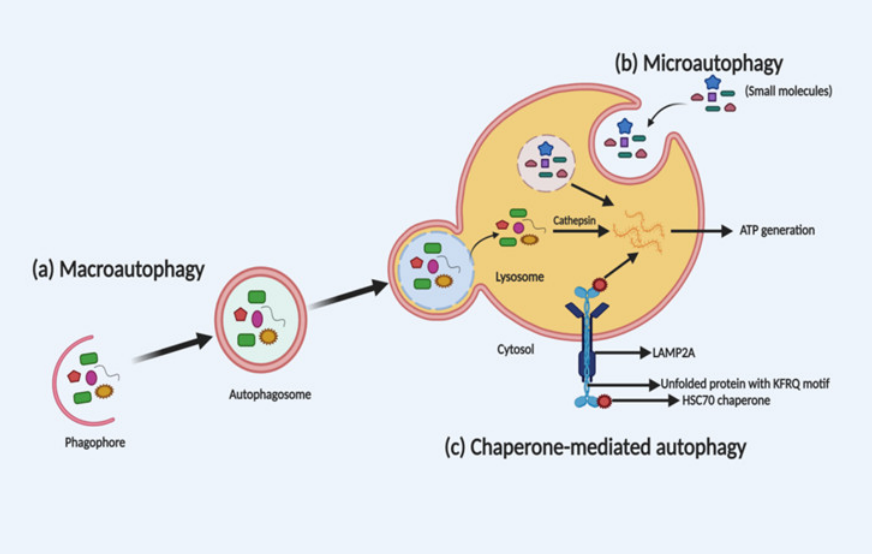
Figure 1. Schematic illustration of the different types of autophagy. Macroautophagy, microau- tophagy and chaperone-mediated autophagy (CMA) are three different types of autophagy based on the selection of the cargo and delivery approach for degradation in the lysosome. In macroautophagy ( a ), autophagosome-mediated degradation takes place by engulfment of dysfunctional organelles and aggregated proteins. In microautophagy ( b ), direct engulfment of small molecules takes place via the lysosome for degradation. Whereas, in CMA ( c ), unfolded proteins with a KFRQ motif is degraded in the lysosomes through receptor-facilitated